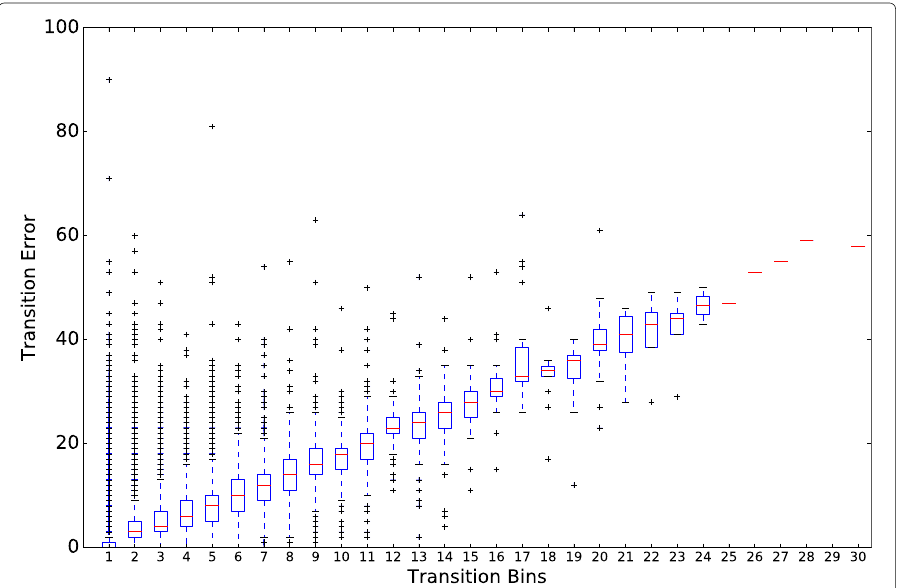
Fig. 3 Correlation between transition bins (bin width = 10 counts) and absolute transition errors